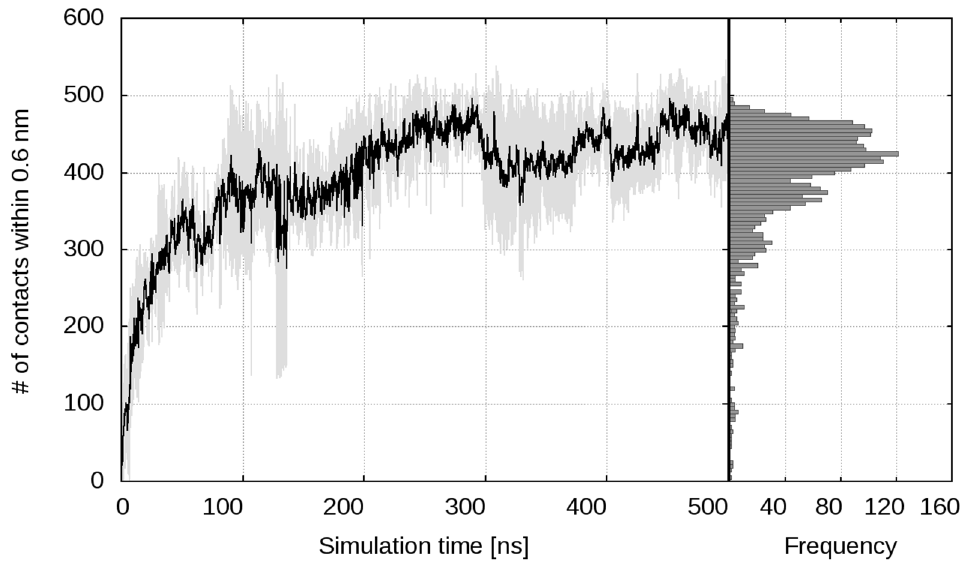
Figure 2. Pair contacts between IFN γ and the hexasaccharides. Number of contacts (averaged over the three independent simulations) as a function of the simulation time between any pair of atoms of IFN γ and any of the four hexasaccharides within 0.6 nm, with the standard deviation band (in grey) and number-of-contact frequencies.